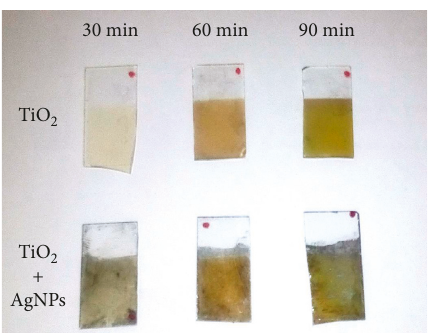
Figure 3: A CCD image showing the fabricated TiO glass substrates before and after AgNP deposition.